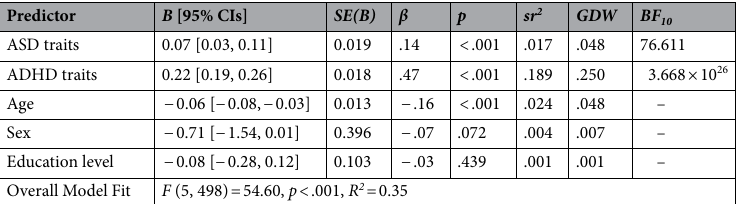
Table 3. Multiple Regression, Dominance and Bayesian Analyses for Anxiety. 95% bias-corrected and accelerated bootstrap confidence intervals for B using 2000 resamples. General Dominance Weight (GDW, with higher values indicating a more important predictor). Sex is coded as 0 = female; 1 = male.